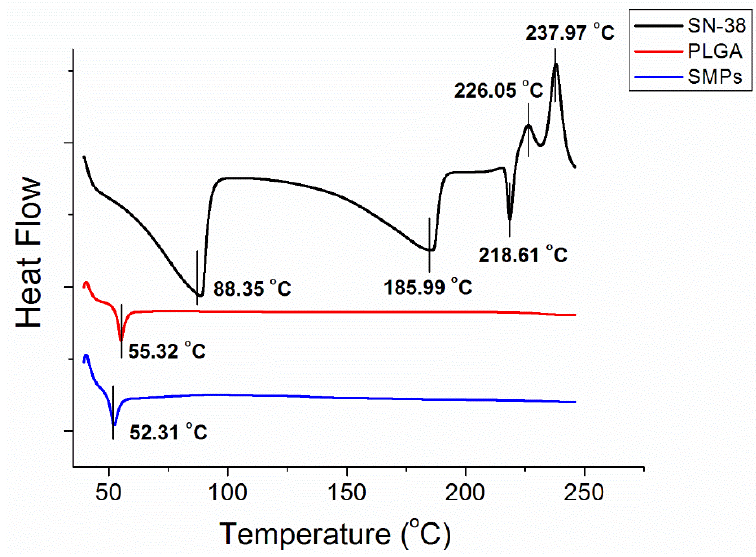
Figure 3. Thermal characteristic of SN-38, PLGA, and SN-38-loaded PLGA microparticles.